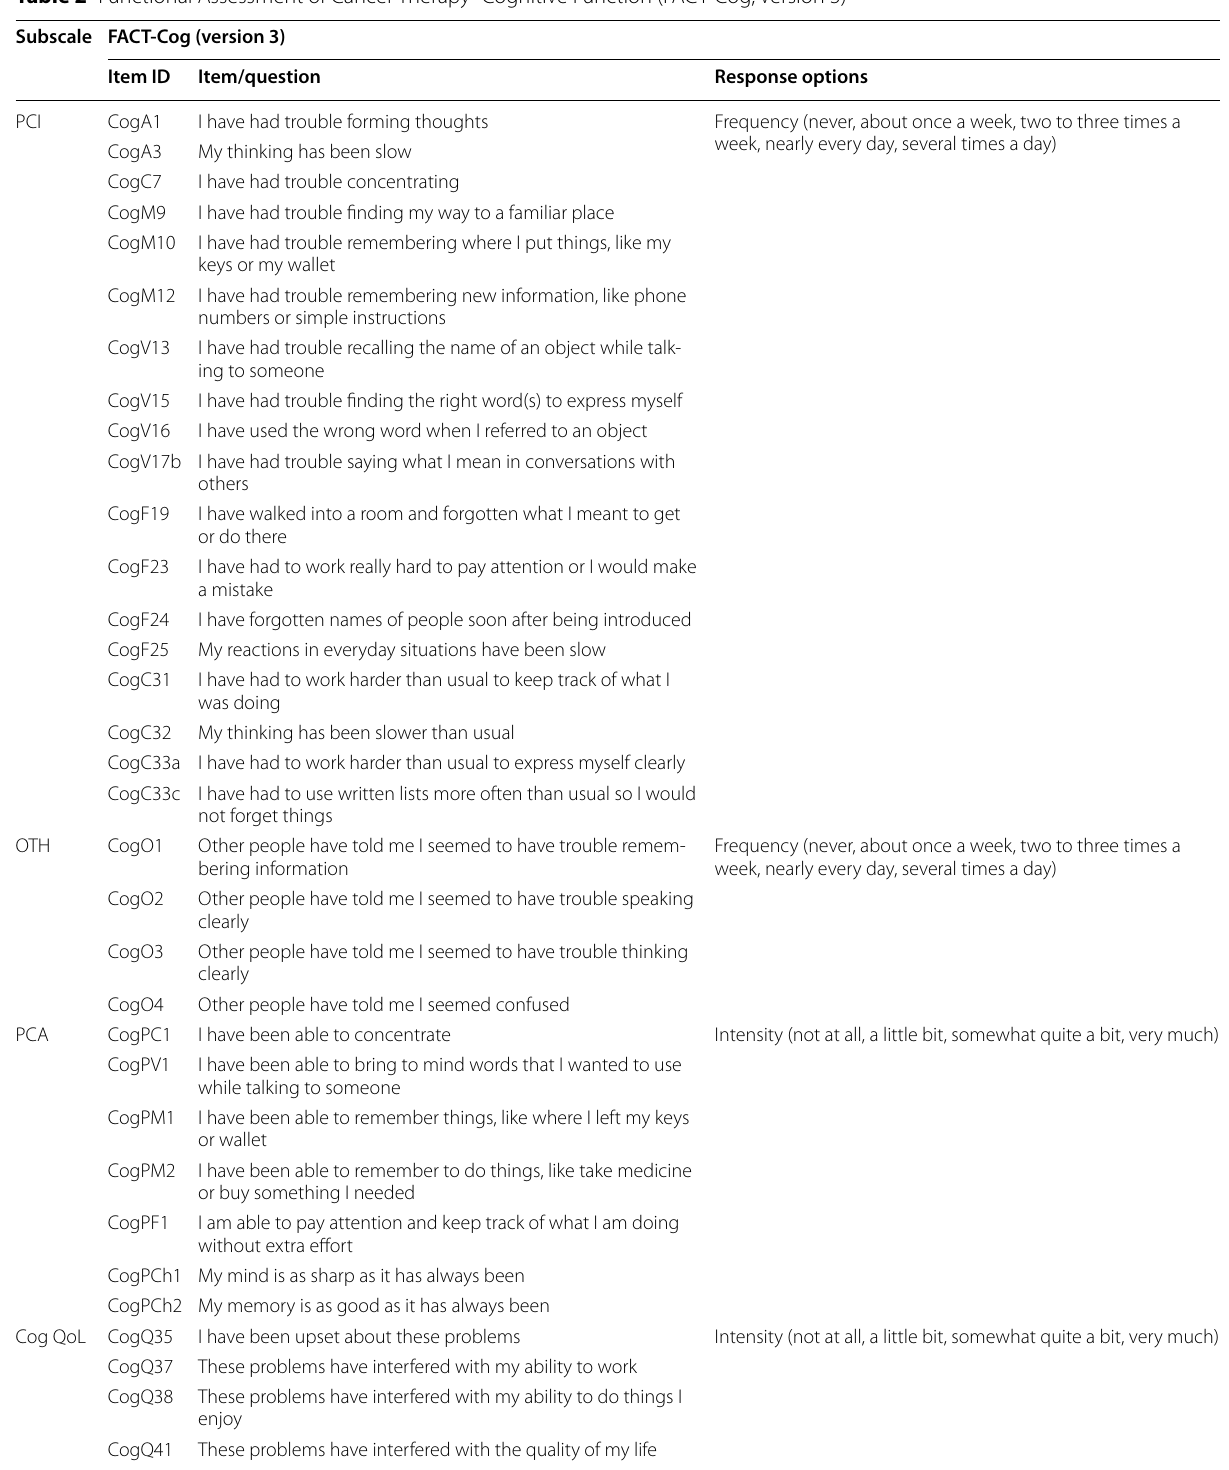
Table 2 Functional Assessment of Cancer Therapy–Cognitive Function (FACT‑Cog, Version 3) Subscale FACT-Cog (version